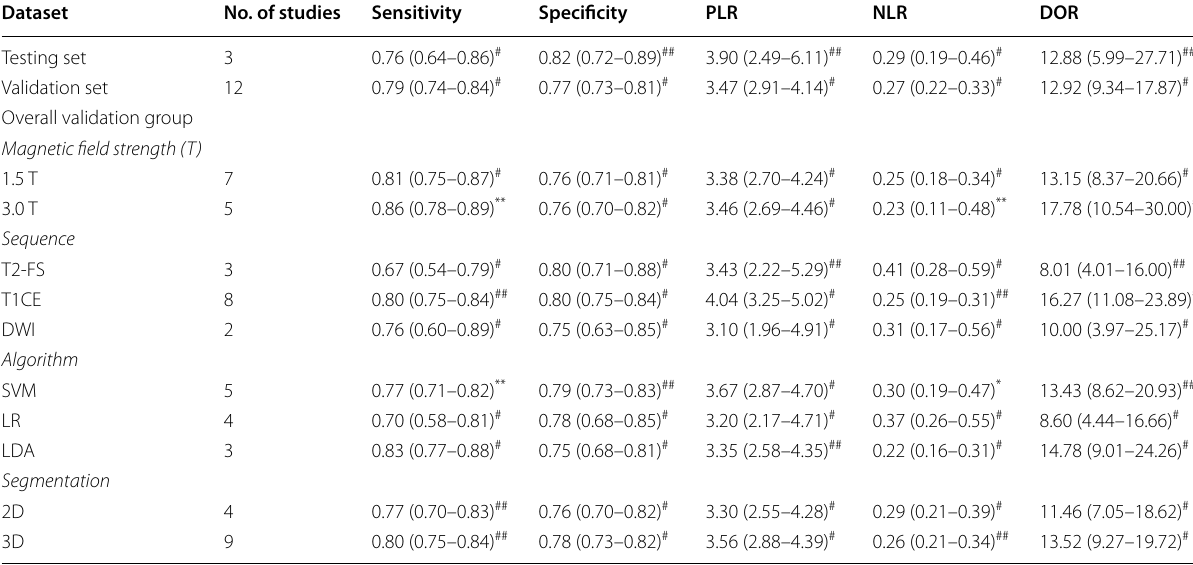
Table 3 The performance evaluation of the datasets and